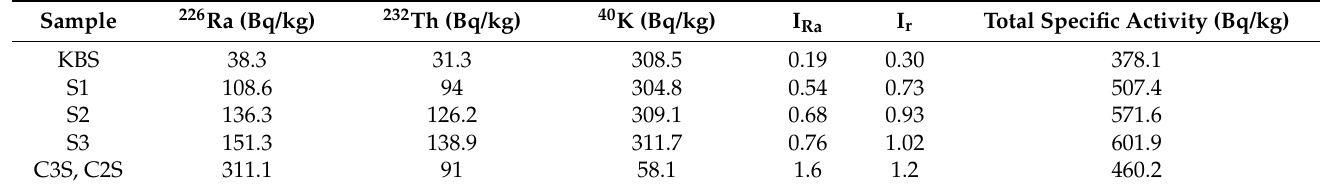
Table 5. Results of specific radioactivity for C X S and clinker of Portland road cement. Sample